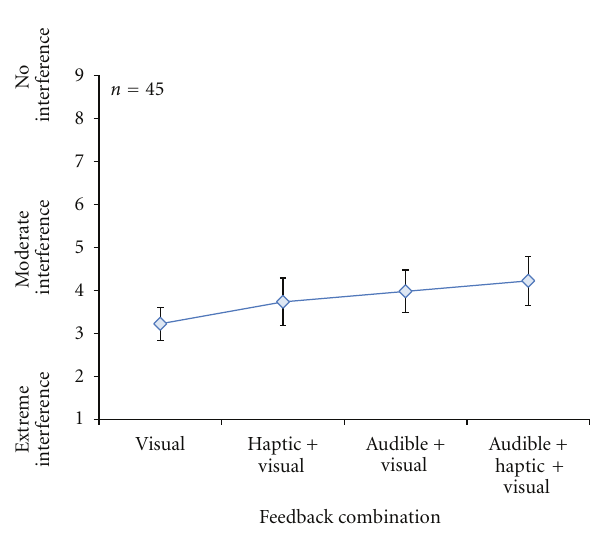
Figure 13: Interference with the driving task.